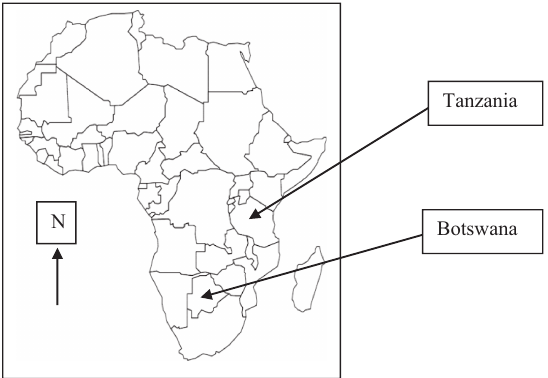
Figure 1. Locations of Tanzania and Botswana in